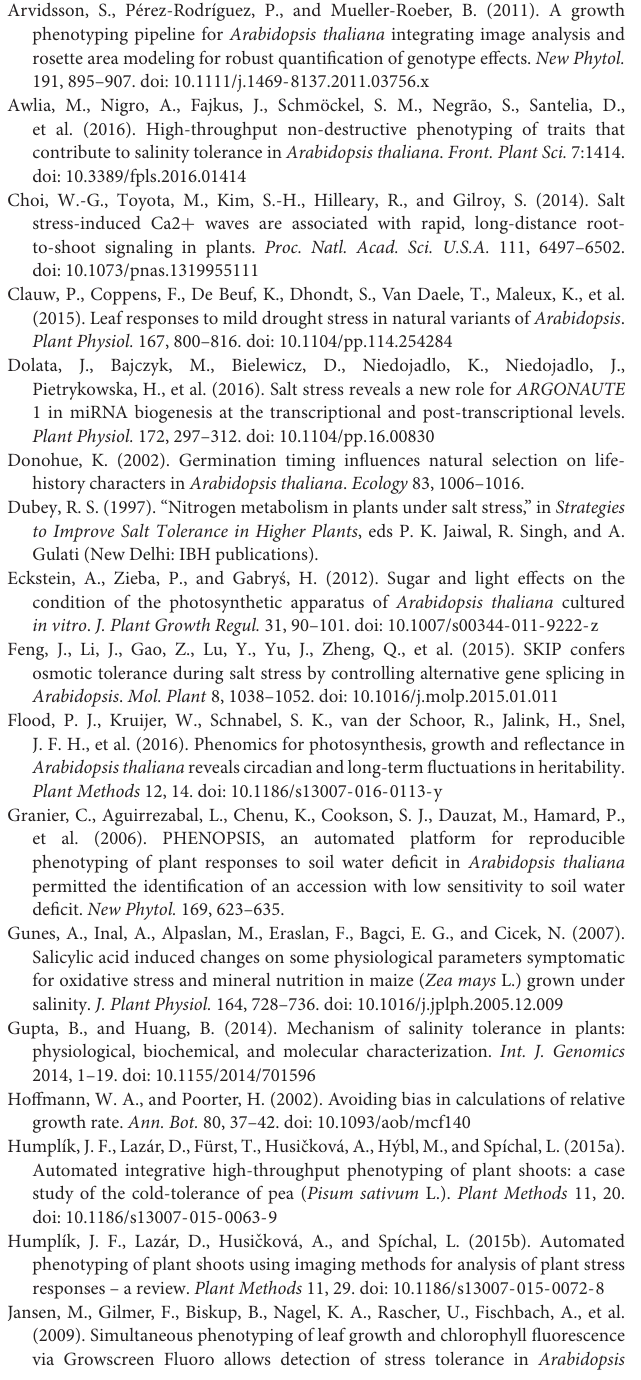
Arabidopsis seedlings grown in 12-well plates containing different MS media with or without 75 mM NaCl for 9 days. Statistical analysis was performed using Kruskal–Wallis’ test. ∗ p < 0.05; ns, non-significant. FIGURE S4 | Distribution of population heterogeneity in Arabidopsis rosette area grown in different MS media with or without 75 mM NaCl for 7